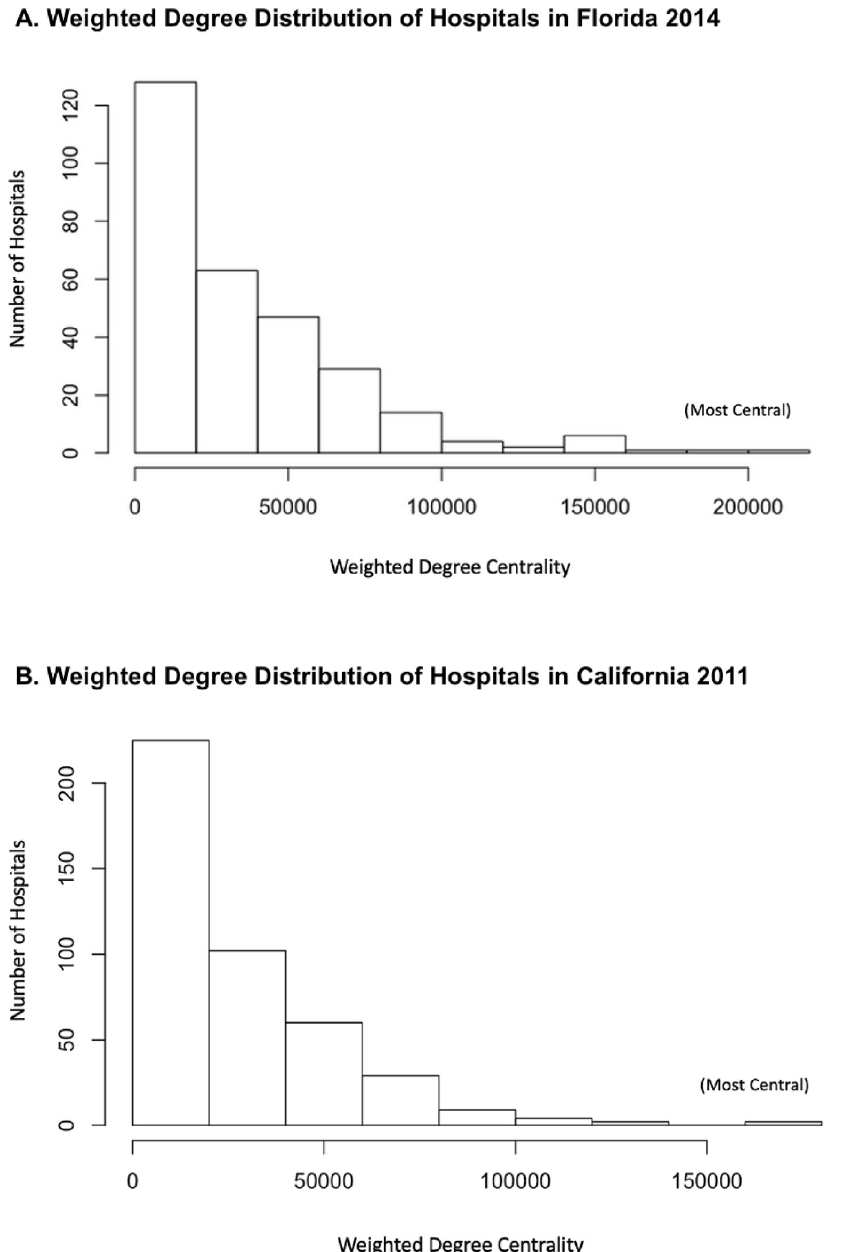
Fig 3. Distribution of weighted degree centrality of hospitals in A) Florida and B) California. These histograms show a high number of low centrality (peripheral) hospitals and a low number of high frequency (hub) hospitals. patients had no comorbidities, while 20.5% had 3 or greater. 60.1% of patients lived in large metropolitan areas, 35.4% in small metropolitan areas, and 4.5% in micropolitan areas. In California, there were 1,415,728 discharges with 30,617 (2.16%) in-hospital deaths. The mean age of patients was 62.0 years (SD 18.4) and 54.3% of patients were females. The study population consisted of 60.9% non-Hispanic white patients, 8.4% non-Hispanic black patients, and 21.1% Hispanic patients. Nearly half of all patients had coverage through Medicare (49%),